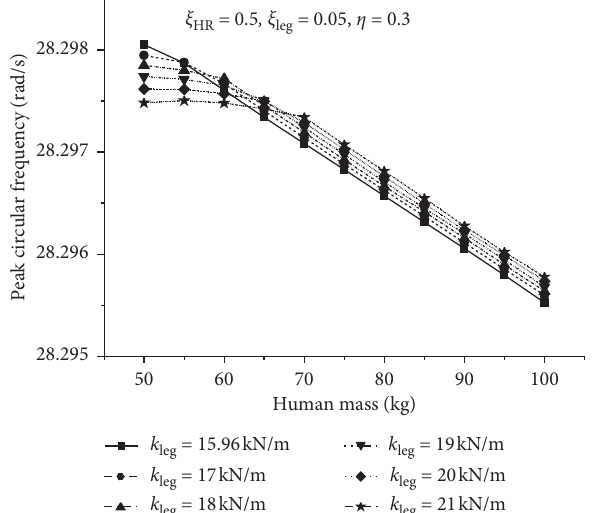
Figure 28: Peak frequency under leg stiffness k � 0 . 5, and ξ � 0 . 05. η � 0 . 3, ξ HR leg